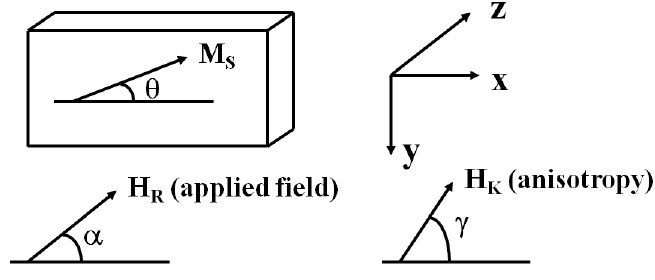
Figure 12. Magnetization, applied magnetic field and anisotropy